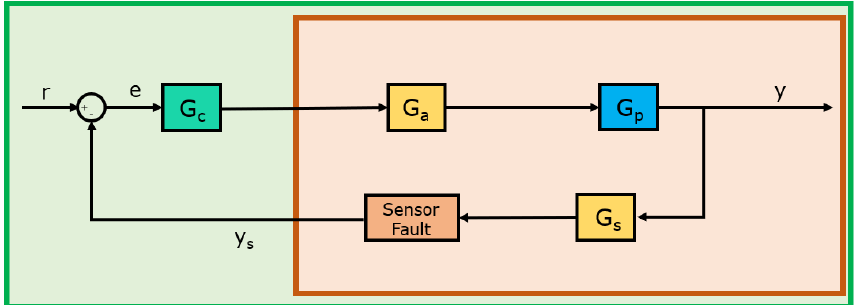
Figure 3. Block diagram of the generalized case study.